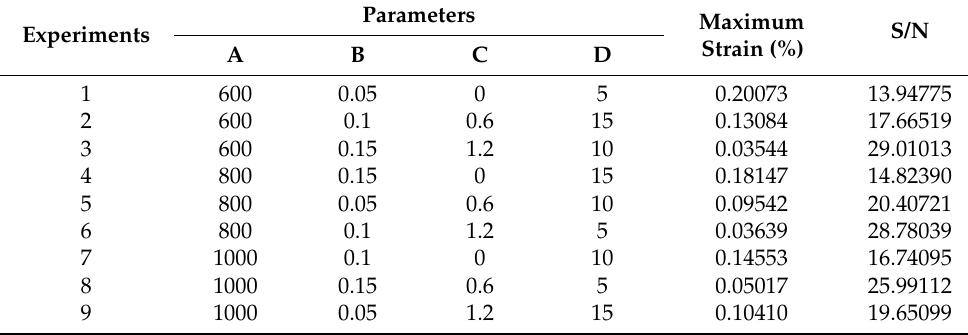
Table 6. Standard orthogonal array for the experiments and